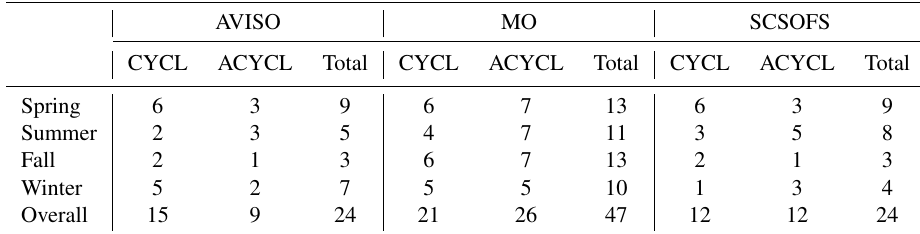
Table 1. Number of eddies for different data types. AVISO MO SCSOFS CYCL ACYCL Total CYCL ACYCL Total CYCL ACYCL Total Spring Summer Fall